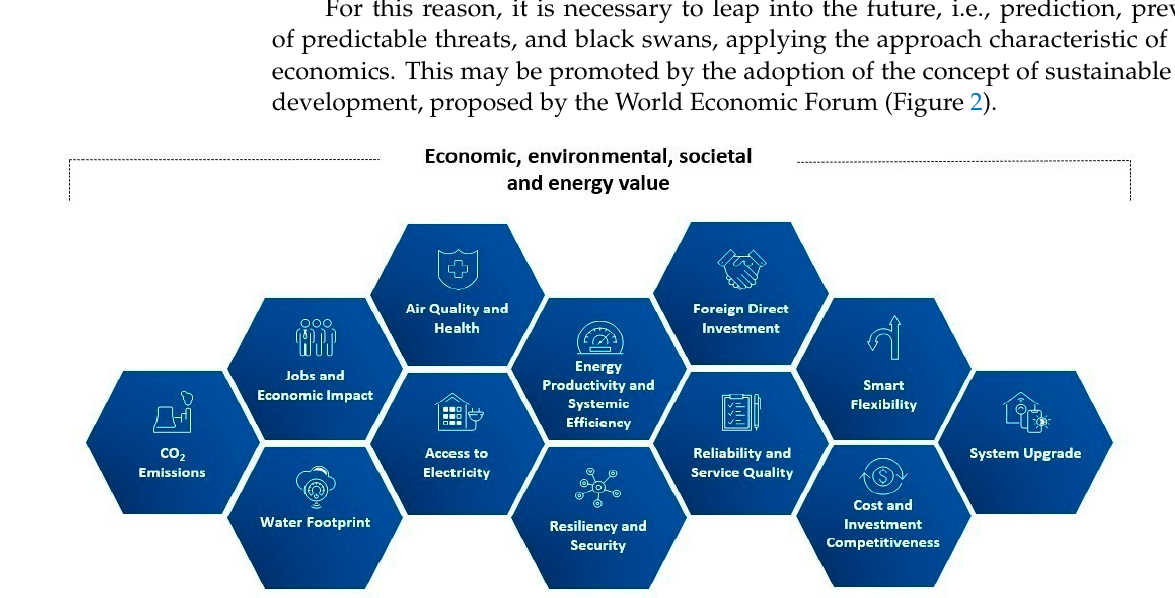
Figure 2. Economic, environmental, societal, and energy value. Source: [48].